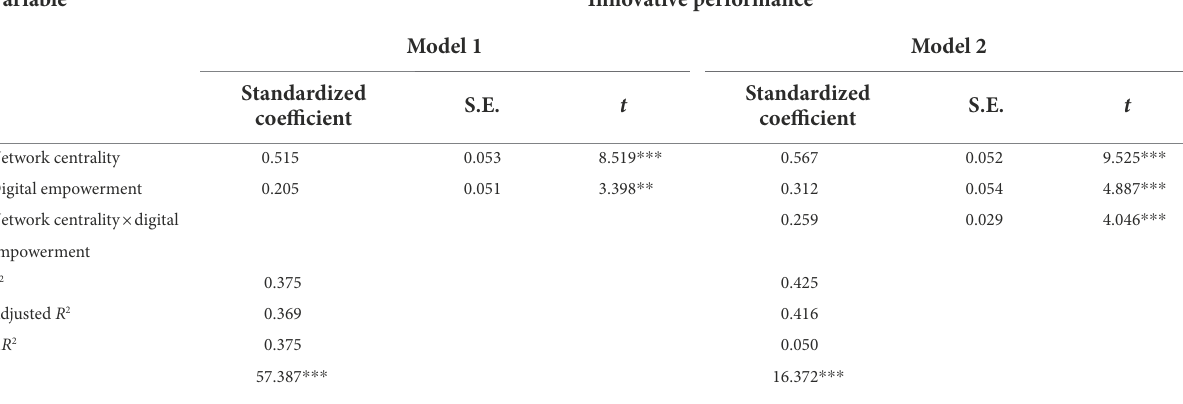
TABLE 10 Test results of the moderating effect of digital empowerment between cluster innovation network centrality and innovation